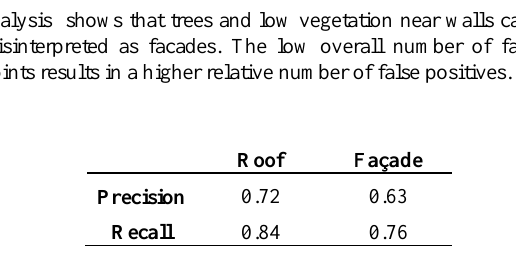
Table 1. Precision and recall of roof and façade classes